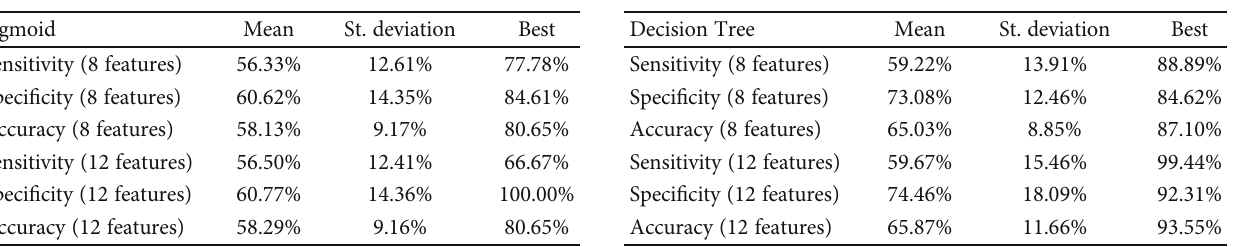
Table 18: Results of Decision Trees.